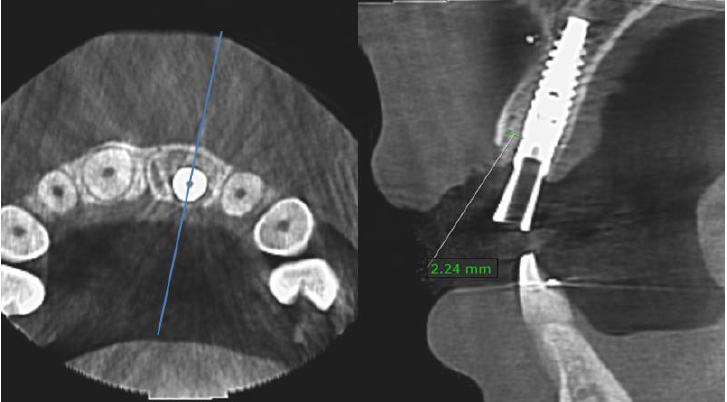
Figure 1. Cross-sectional measurement of the mid-buccal (blue line) gap size using CBCT.